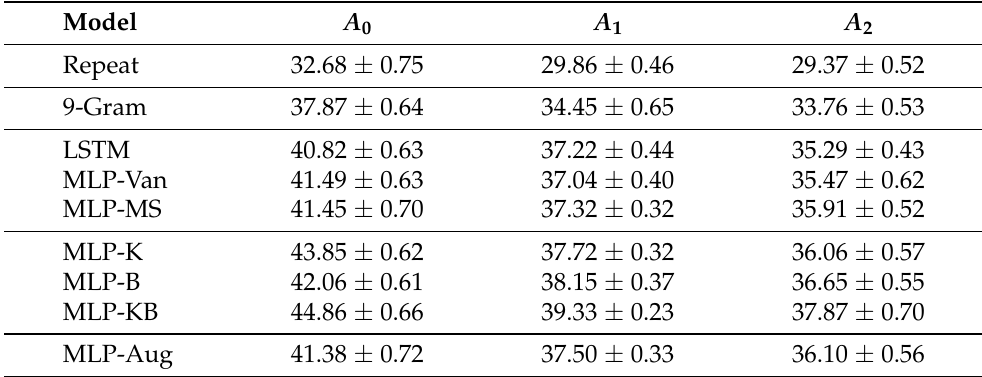
Table 7. Mean prediction accuracy and the standard deviation for each method over the chord alphabets A 0 , A 1 and A 2 on the